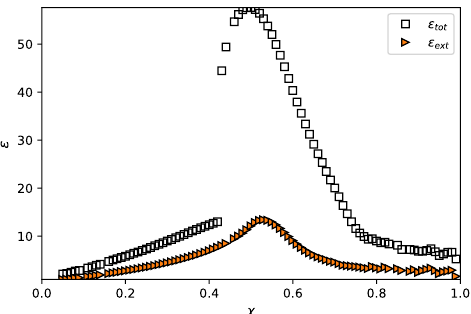
Figure 7. Width of the range of Gaussian fluctuations of the non-stretched terminal segments of the chains (square marker). and the size of the tail in the polymer density profile protruding above z = H (triangle marker) as a function of χ -parameter for the brush of linear chains, grafted to a planar surface, R = ∞ for N = 1000, σ =